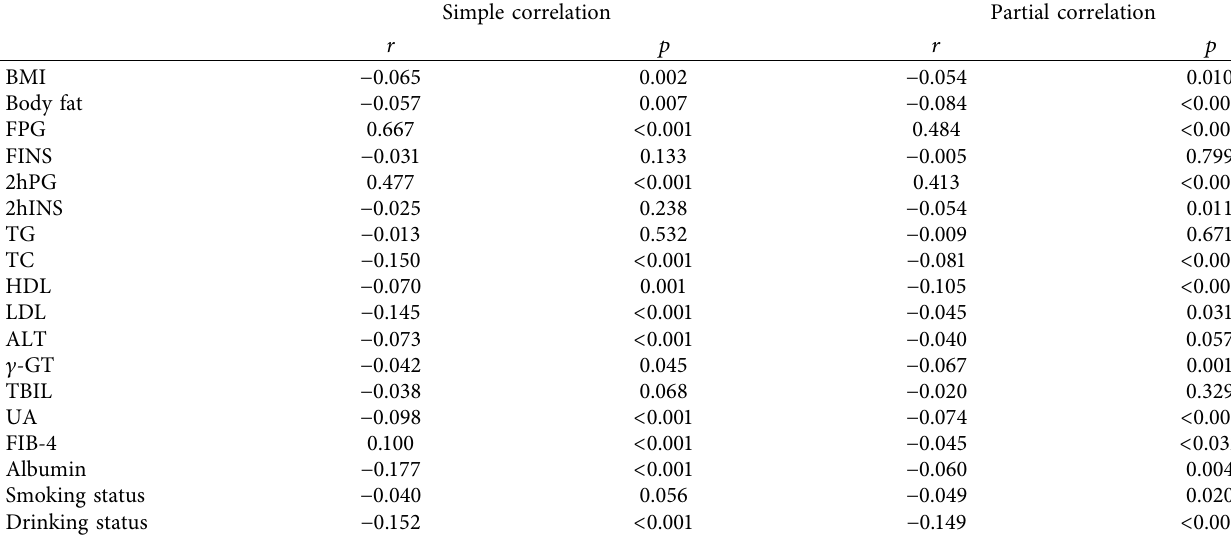
Table 3: Correlation analysis of glycated albumin and other